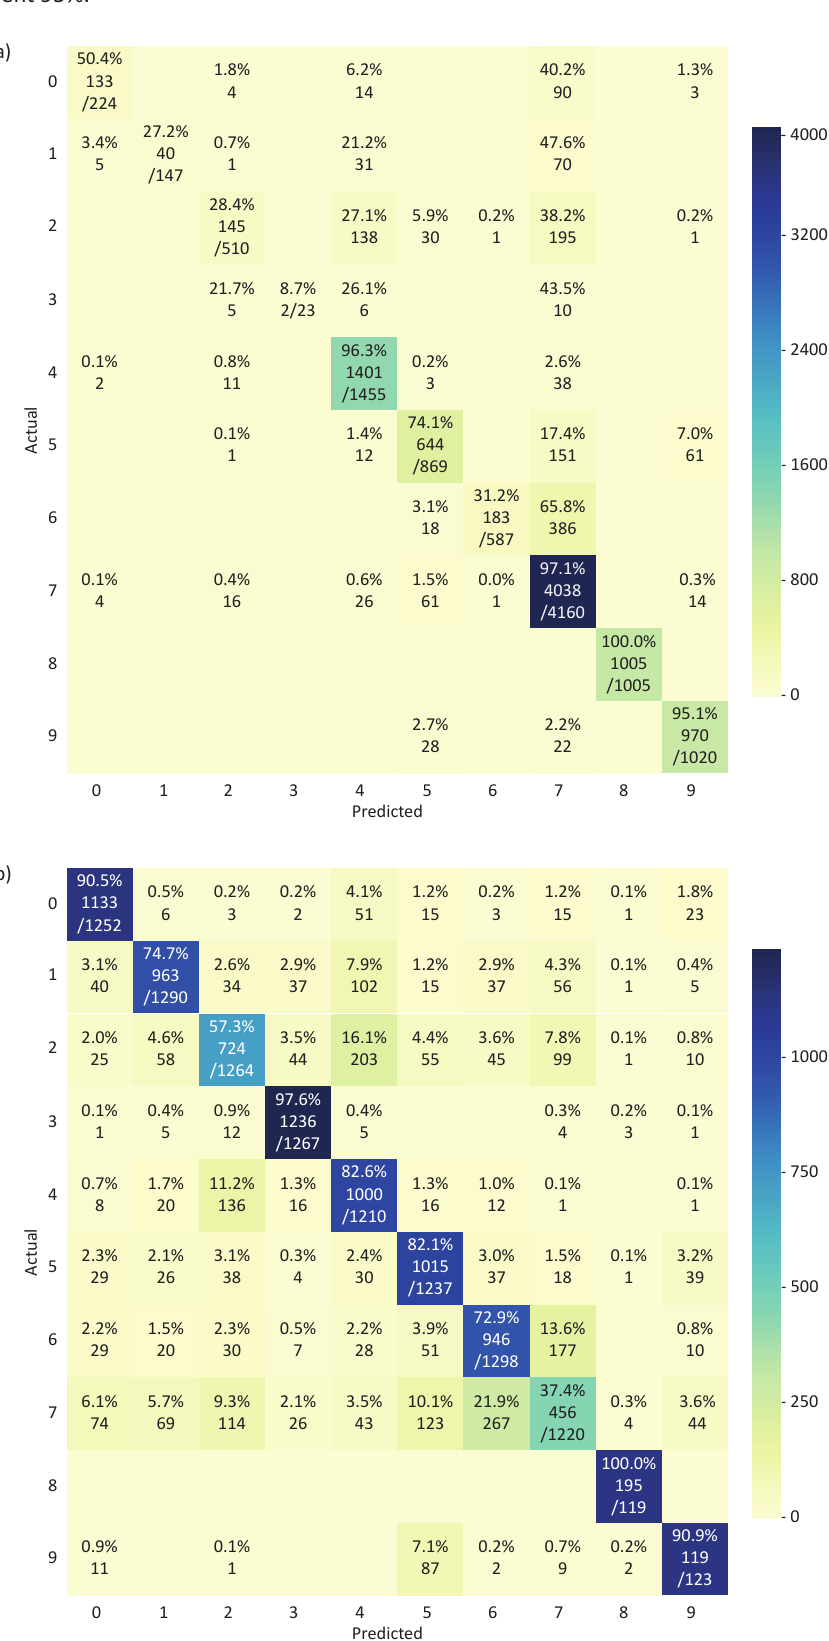
Fig. 8. Confusion matrices for the (a) unbalanced and (b) balanced